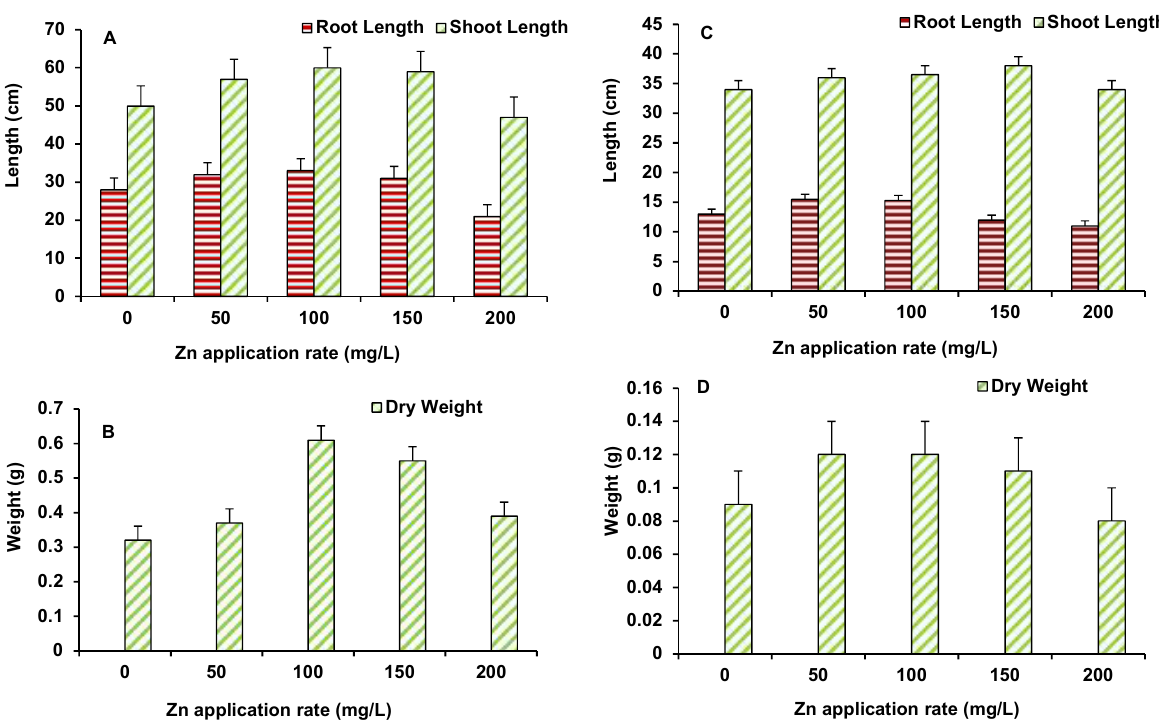
Plants 2021 , 10 , x FOR PEER REVIEW Figure 4. Effect of ZnO NPs treatment on root and shoot length ( A , C ), and dry weight ( B , D ) of maize ( A , B ) and wheat ( C , D ). Values are means of four replicates. Error bars indicate the least significant value (LSD) at p ≤ 0.05 among the treatments.